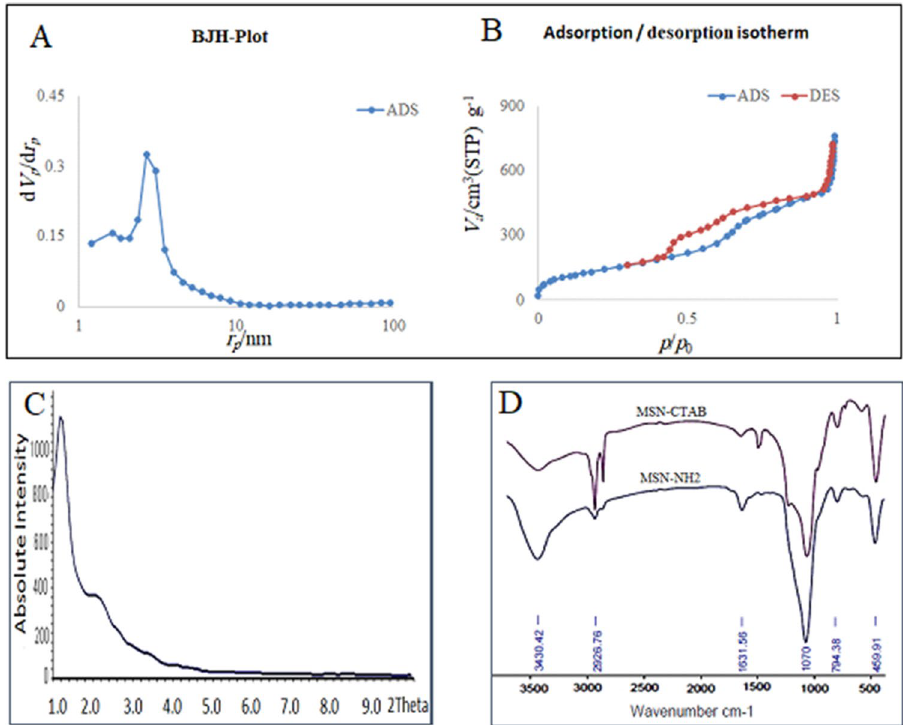
Figure 2. The distribution of pore sizes and the isotherms of nitrogen adsorption/desorption in MSN-NH 2 ( A , B ). MSN-NH 2 XRD patterns revealed the locations of the peaks associated with the mesoporous silica structure ( C ). The FTIR spectra obtained before and after CTAB extraction from MSNs confirmed the successful elimination of CTAB and the addition of the aminopropyl moiety ( D ).